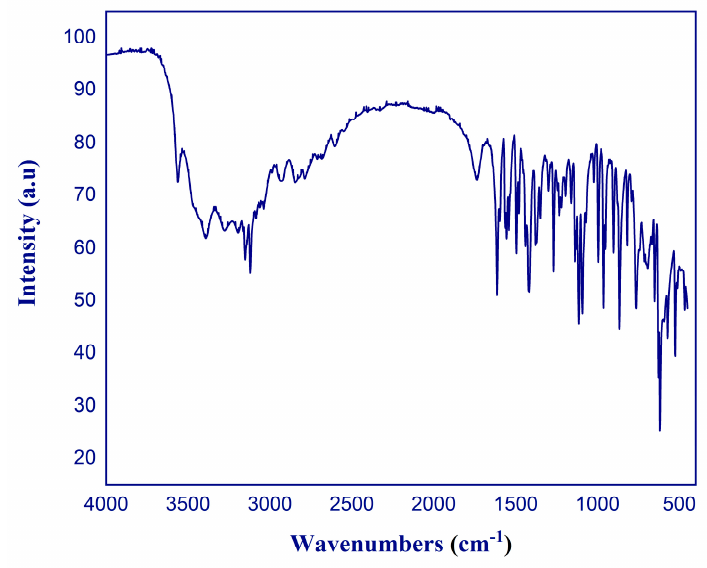
Figure 7. Experimental IR absorption spectrum of (H2Fluconazole).SnCl 6 .2H 2 O recorded at room temperature. Table 4. Attribution of the experimental and calculated IR frequencies (cm − 1 ) of (H2Fluconazole).SnCl 6 .2H 2 O. Experimental